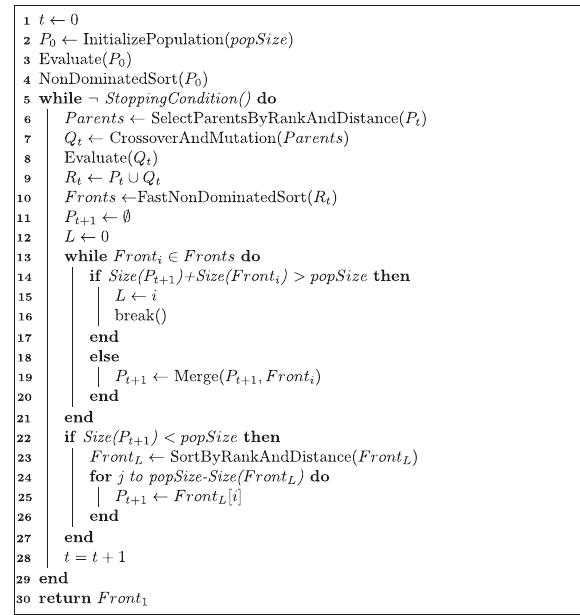
Figure 8: Pseudocode of